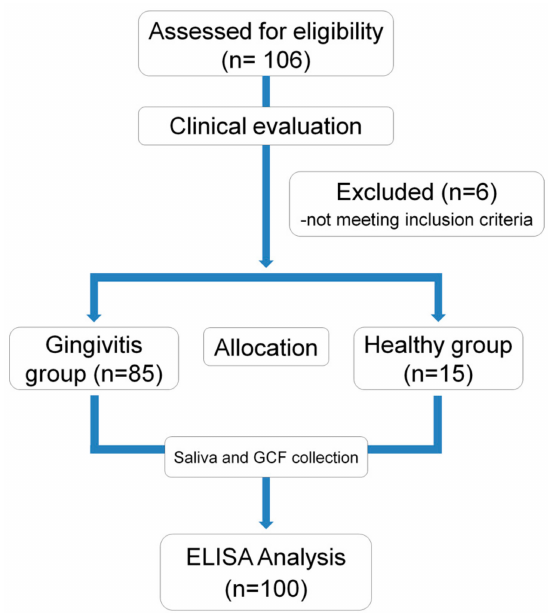
Figure 1. Flowchart and study protocol. GCF, gingival crevicular fluid; ELISA, enzyme-linked immunosorbent